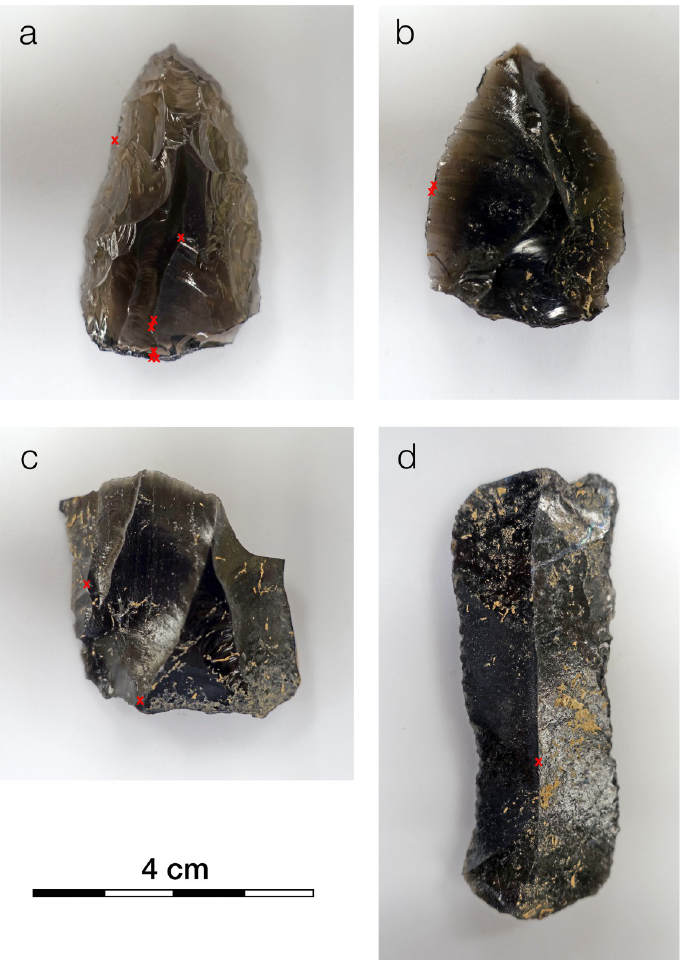
Fig 4. Four of the twelve LKT1 artifacts examined with μ FTIR. Locations (the red X symbols) on a: G04-1026, b: H05-699, c: H05-477, and d: I05-1051 with the presence of organic residues identified by VLM and SEM. Residues on these artifacts are discussed in the text. Photographs by the first author